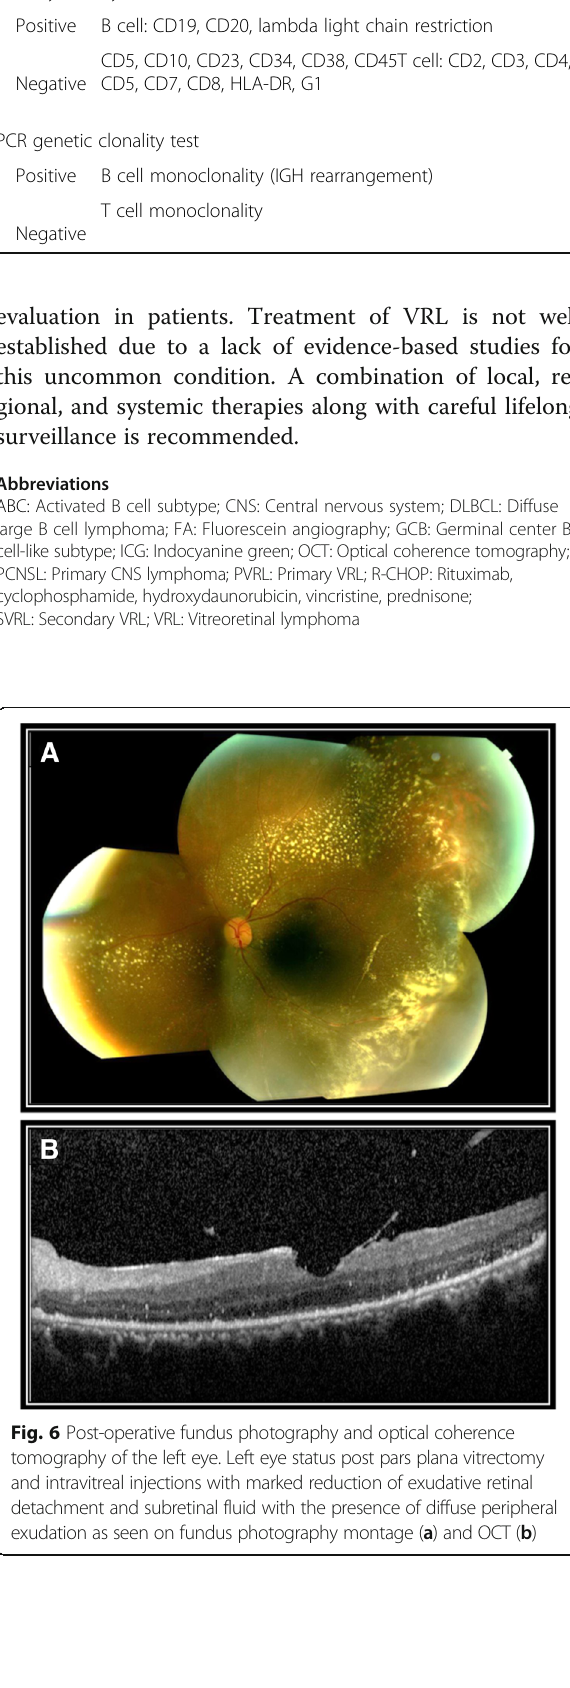
Table 1 Left eye vitreous biopsy results Flow cytometry Positive B cell: CD19, CD20, lambda light chain restriction